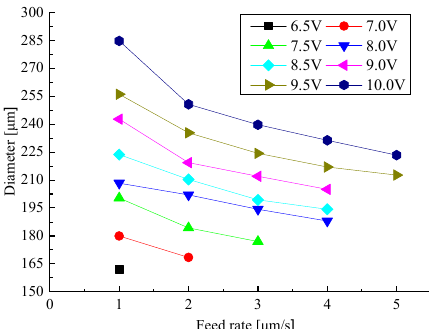
Figure 6. Relationship between diameter and feed rate for different values of applied voltage.